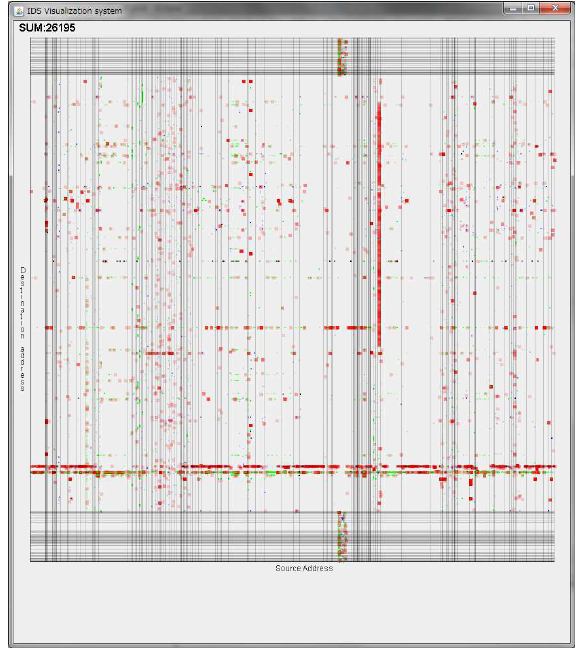
Figure 15: Unequal Scaling visualization system with emphasizing anomalous